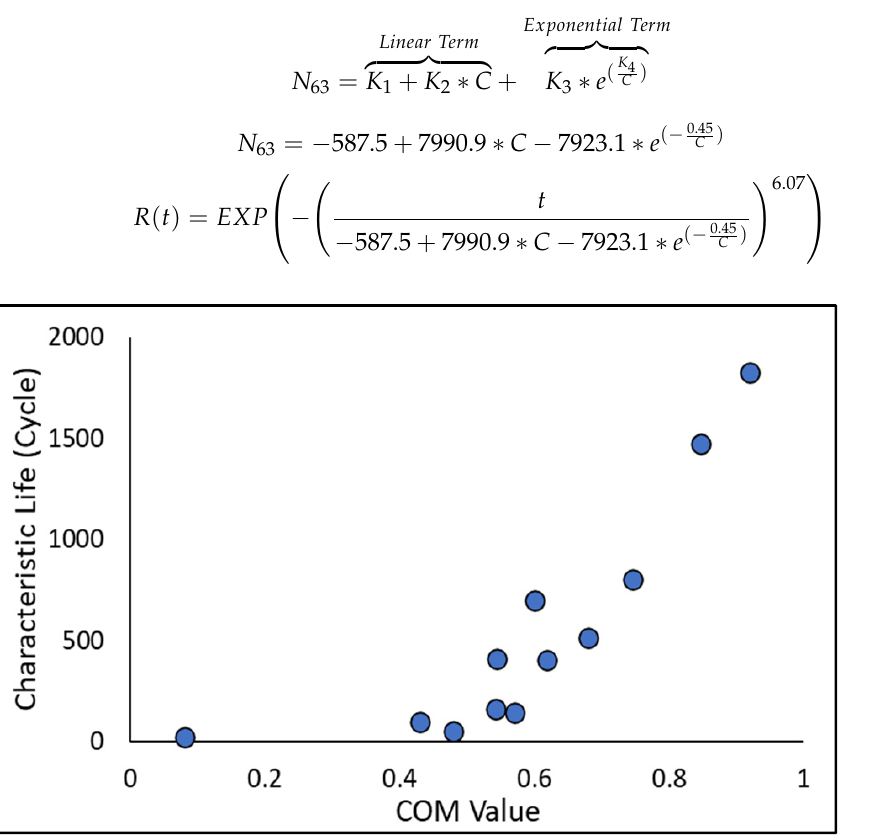
Figure 13. COM-Value versus characteristic life.